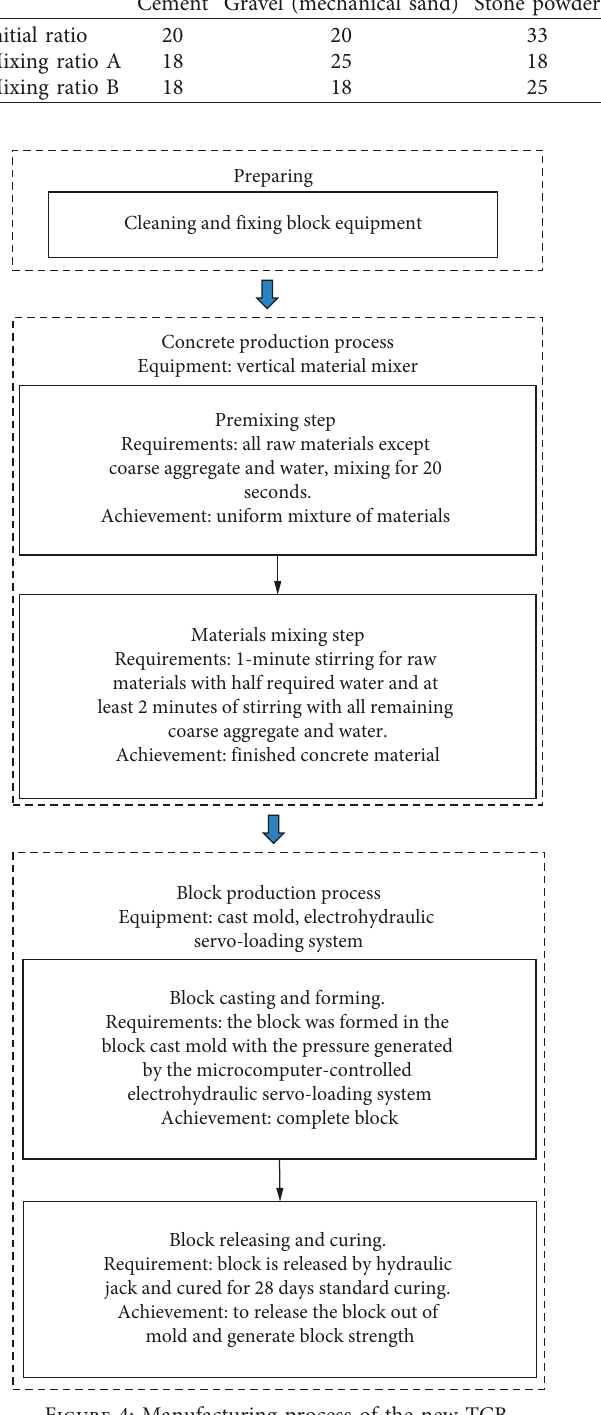
Figure 4: Manufacturing process of the new TCB.